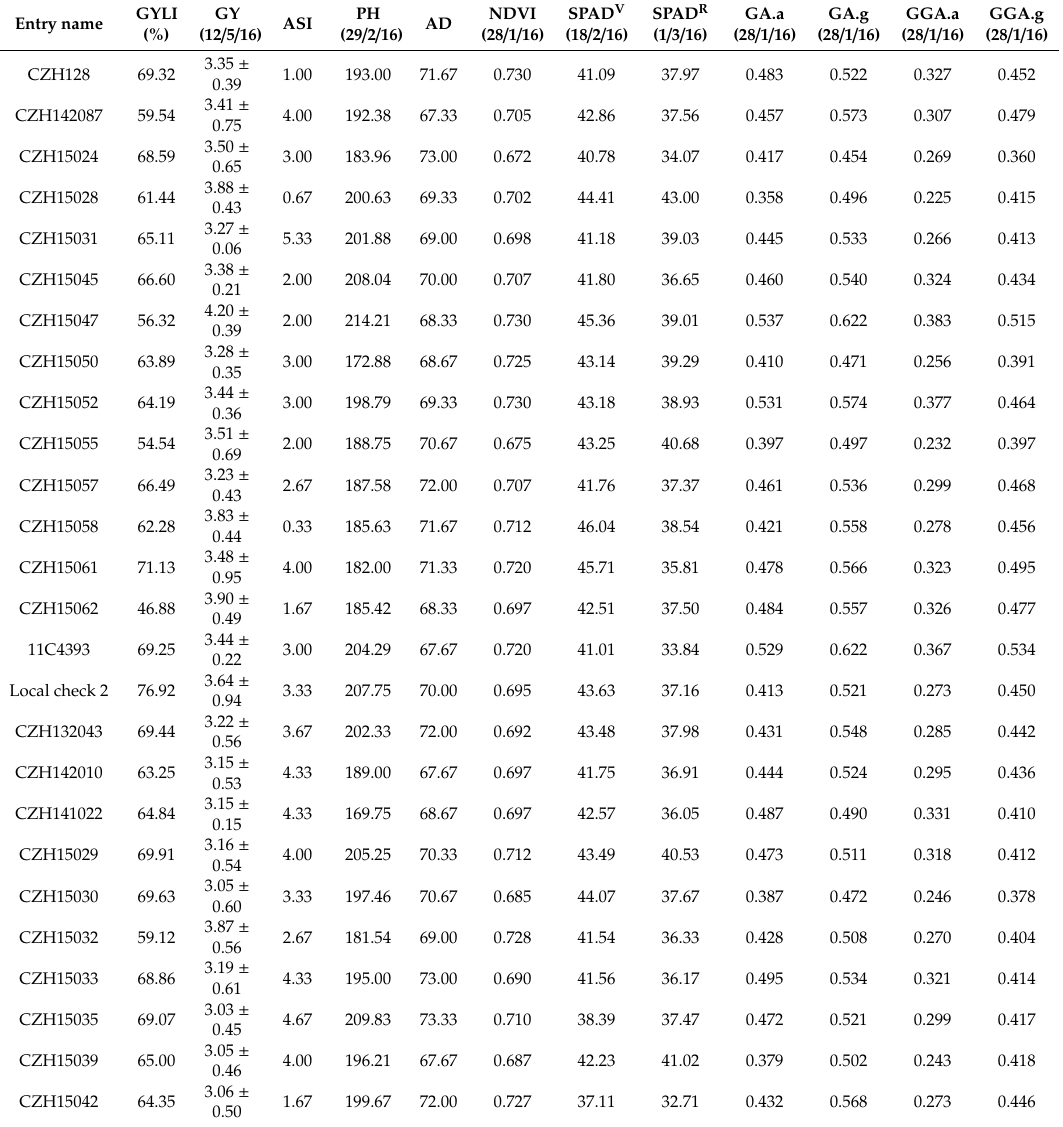
Table A2. Descriptive data of GY, LOW, GYLI, ASI, PH, AD, NDVI, SPAD V , SPAD R , GA, and GGA according to the quartiles HY, MHY, MLY, and